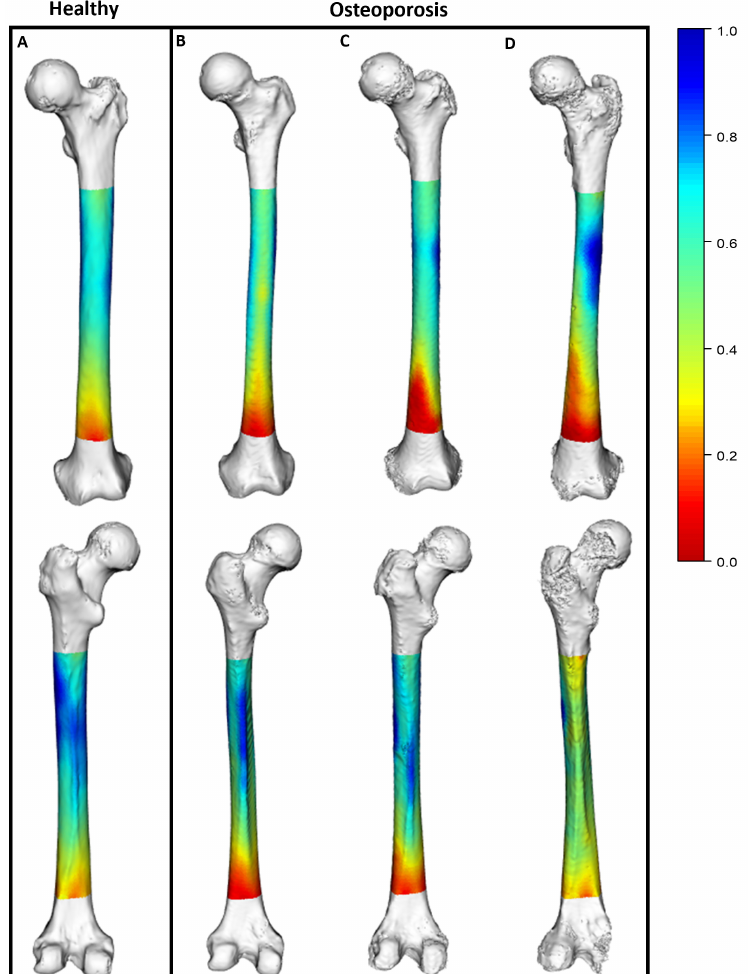
Figure 1. Three-dimensional models exhibiting disparities of morphological data between healthy and osteoporotic femurs. Heat maps show scaled bone thickness data corresponding with each location on the femur. (High thickness depicted in blue, ranging to low thickness shown in red). ( A ) Healthy femur. ( B – D ) Three examples of femurs with osteoporosis. Anterior view (above) and posterior view (below) are